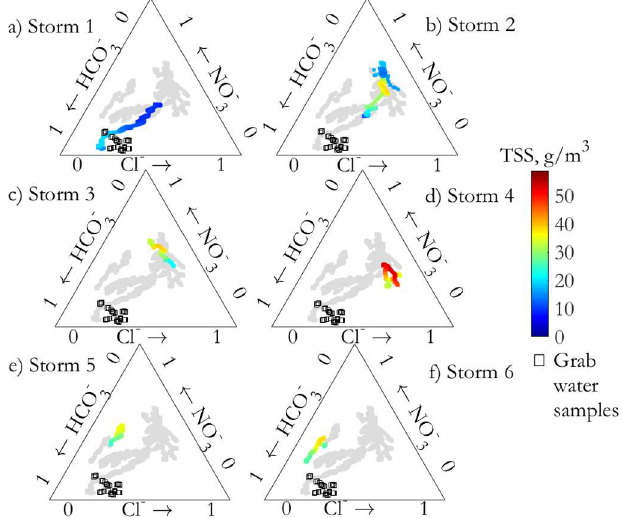
Figure 7. Anions diagram of HCO 3 − , NO 3 − and Cl − during six rainstorms ( a – f ) in conjunction with total suspended sediments (TSS) and grab water samples ( ) for location Q1 in the Kanawha River, West Virginia (gray footprint corresponds to all measurements of Figure 4).